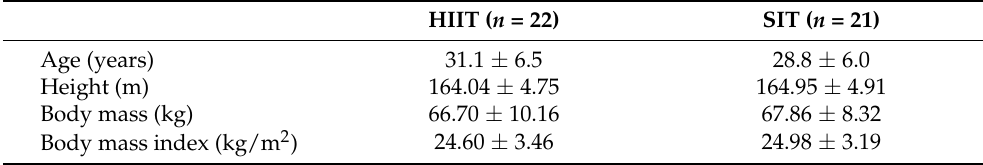
Figure 1. Flow diagram of participants. Table 1. Anthropometric characteristics of participants before interval training intervention.